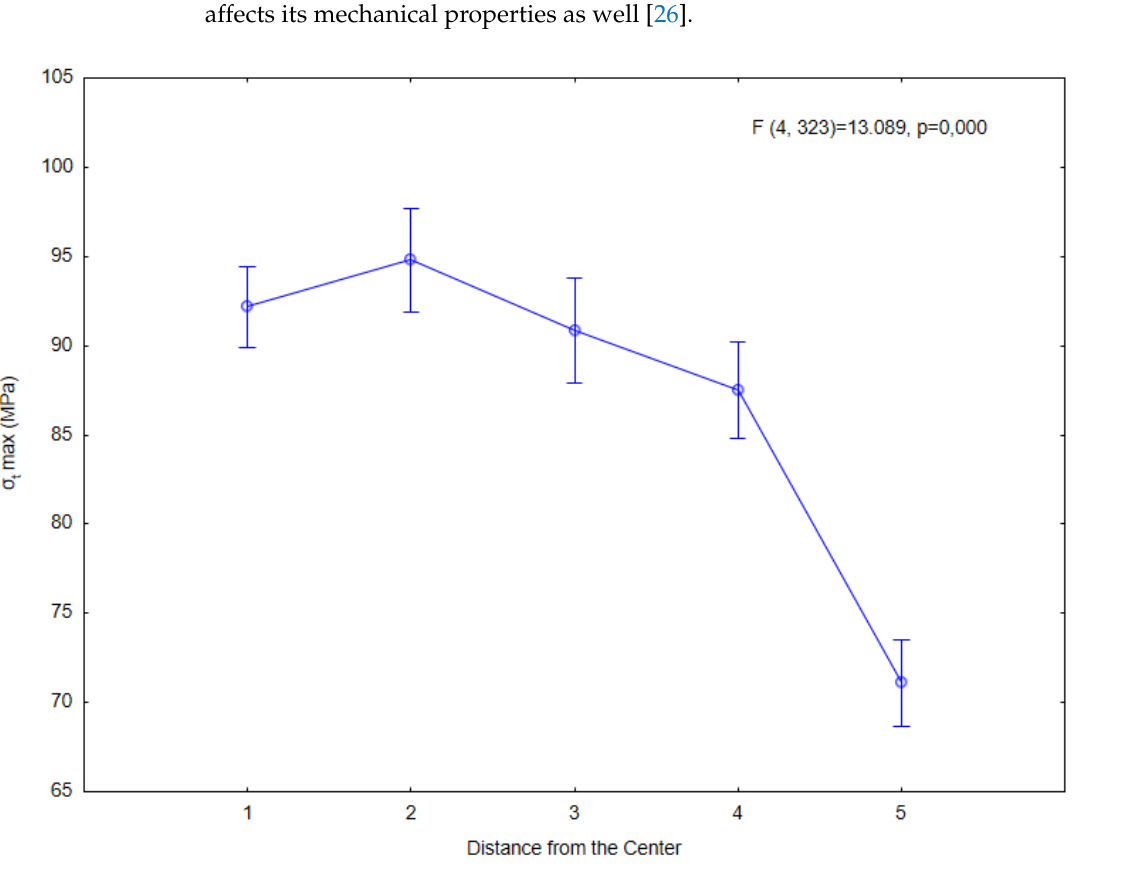
Table 5. ANOVA spreadsheet — Age of log and distance from center — influence on tensile strength.